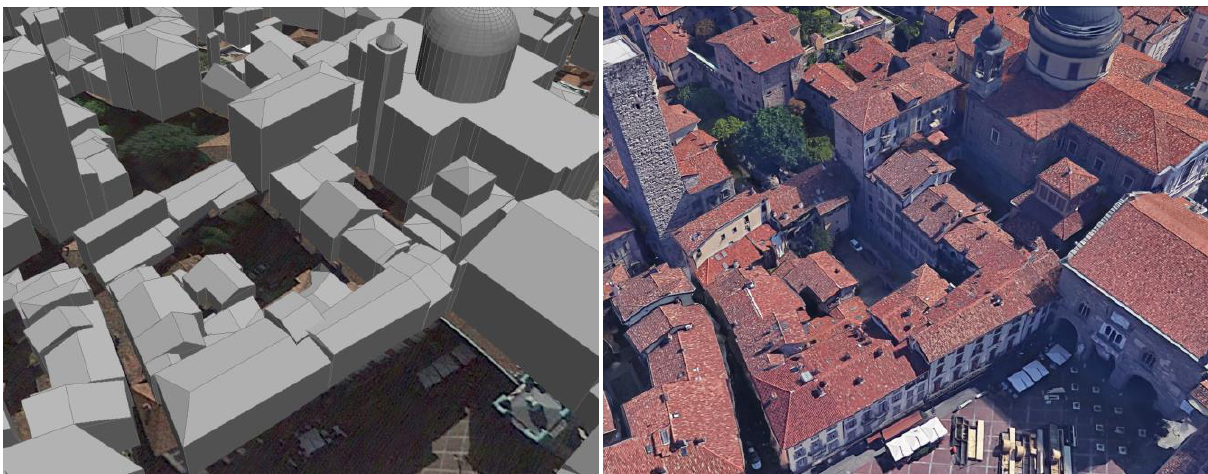
Figure 8. Modelled 3D buildings (left) and real shapes (rights, from Google Earth) in the hearth of the historic centre with its complex roofs.